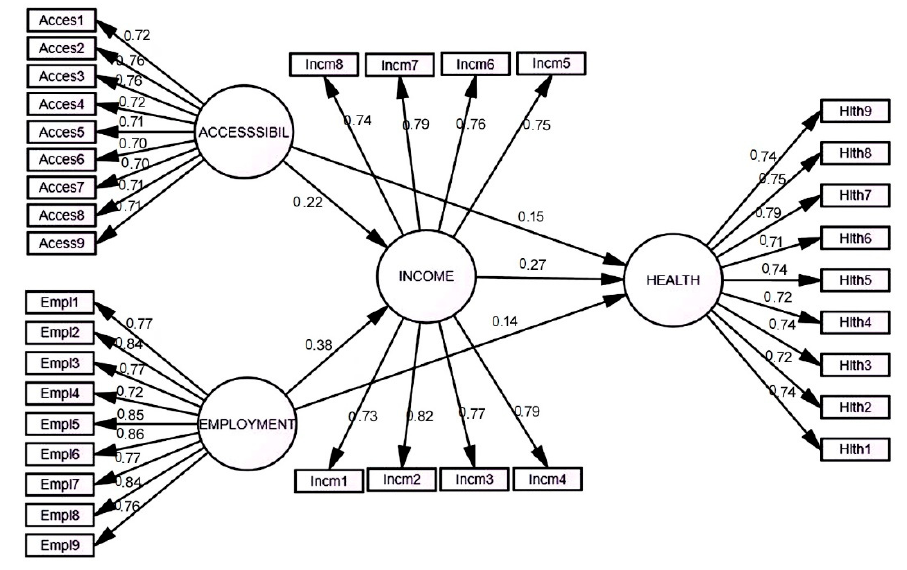
Figure 2. SEM Result.